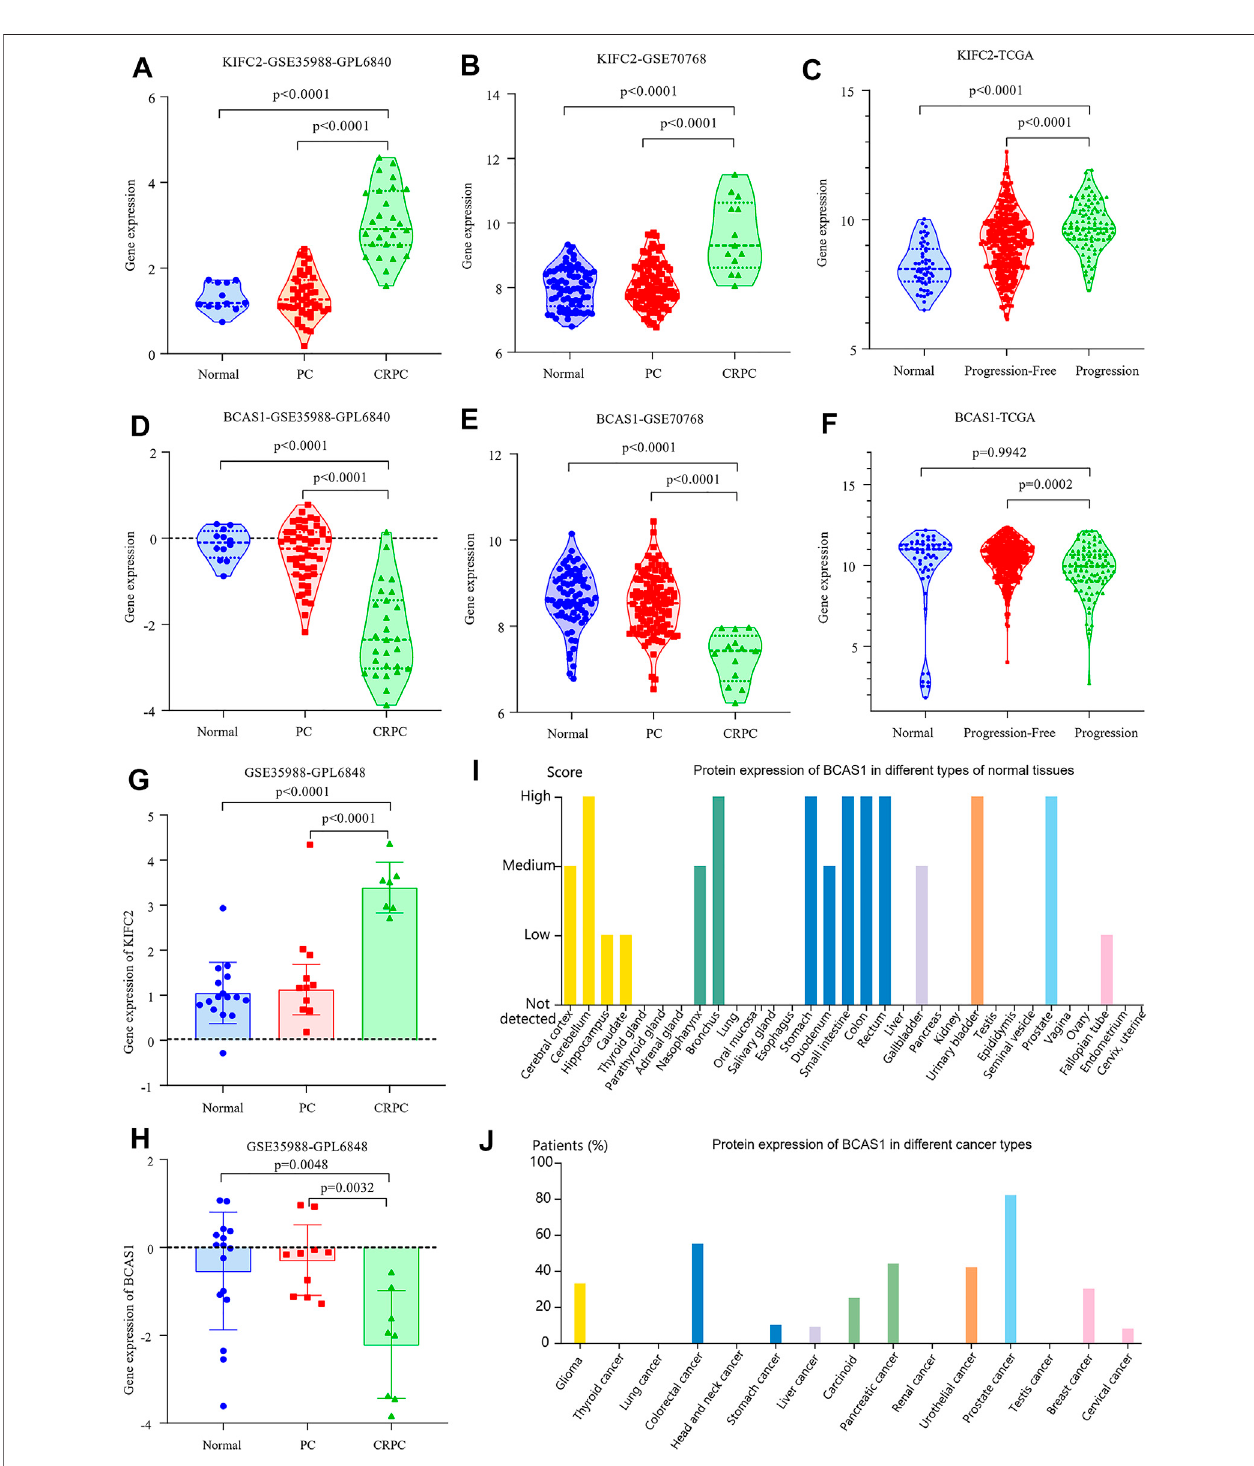
FIGURE 10 | Expression of KIFC2 and BCAS1. (A,B,G) The gene expression of KIFC2 is higher in CRPC than in normal and PCa samples. (D,E,H) The gene expressionofBCAS1islowerinCRPCthaninnormalandPCasamples. (C,F) WhilethegeneexpressionofKIFC2ishigherinpatientswithprogression,thatofBCAS1is lower in patients with progression. (I,J) The protein expression of BCAS1 is high in many normal tissues including prostate but low in most cancer types excluding prostate cancer.